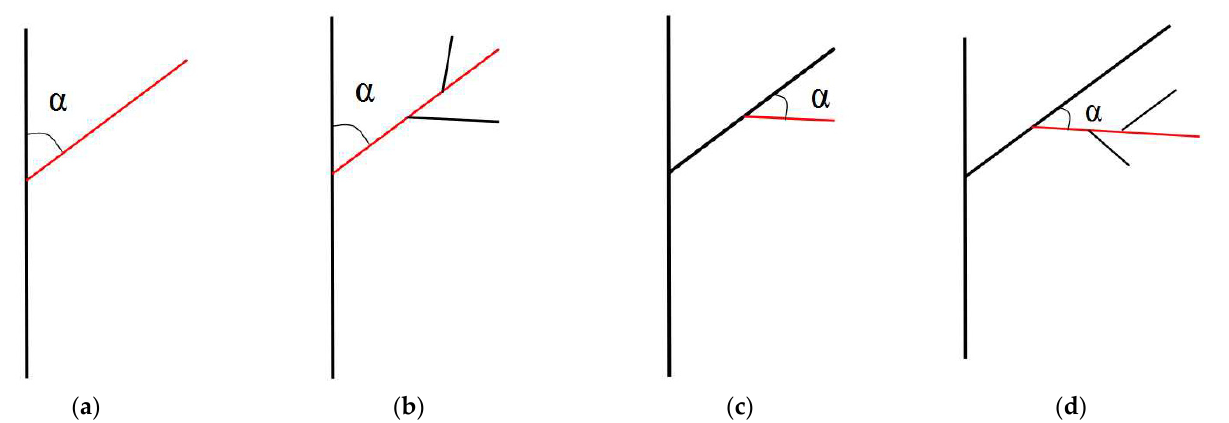
Figure 2. Four branch types: ( a ) type I, upper branches in the vertical plane, with no lower branches; ( b ) type II, upper branches in the vertical plane, with lower branches; ( c ) type III, superior branches in the (approximately) horizontal plane, with no lower branches; ( d ) type IV, superior branches in the (approximately) horizontal plane, with lower branches.